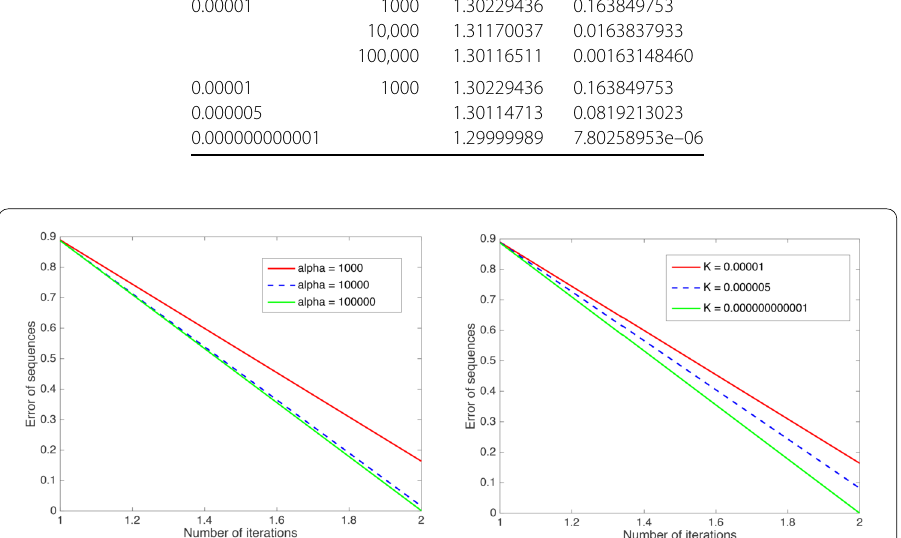
Table 2 Approximation of substrate concentration sequence S ( x ) for different values of α and K K α